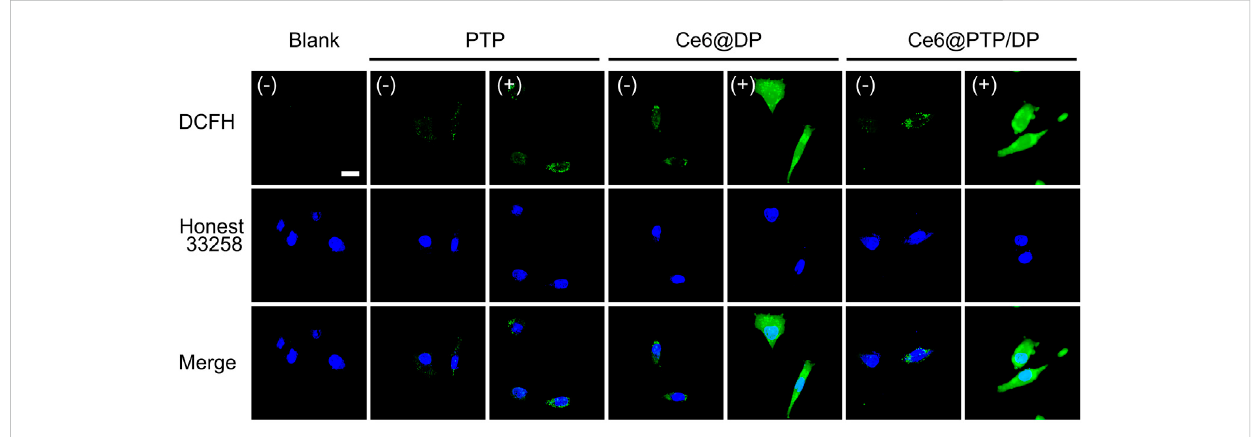
FIGURE 6 ROS generation studies of PTP, Ce6@DP and Ce6@PTP/DP micelles in HeLa cells. Using DCFH-DA as general ROS fl uorescence indicators (green) and the nuclei were stained by Hoechst 33258 (blue), respectively.